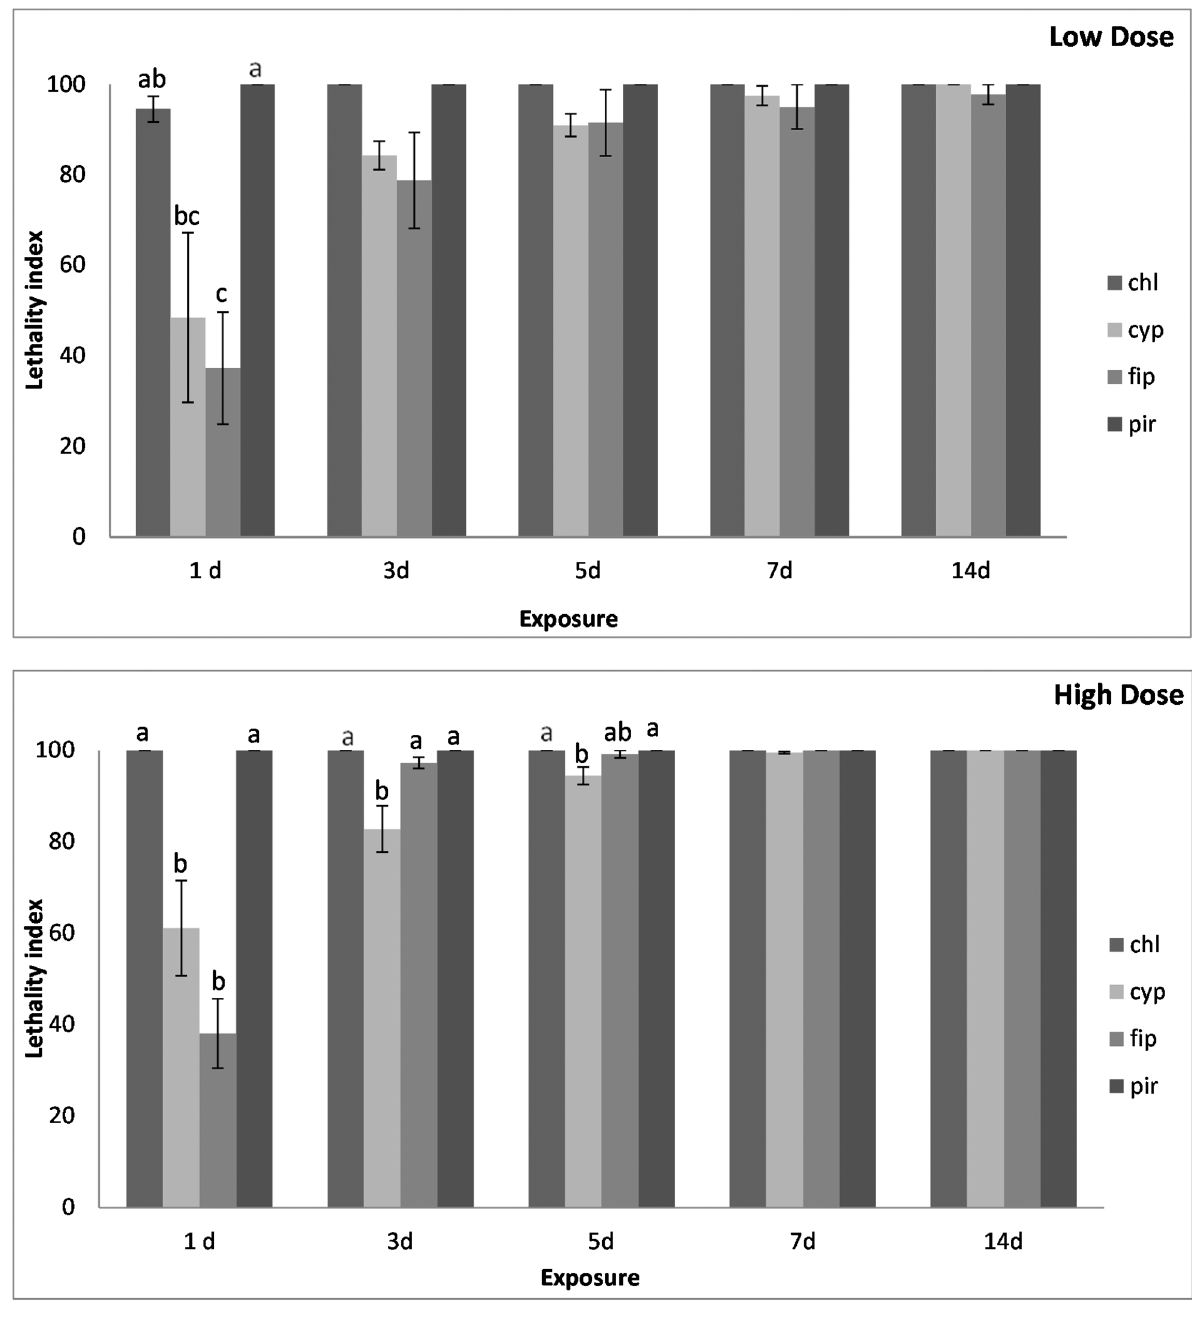
Fig 7. Lethality index of O . surinamensis adults on concrete surfaces at low and high dose. Mean lethality index ( ± SE) of O . surinamensis adults on concrete treated with chlorfenapyr (chl), alpha-cypermethrin (cyp), fipronil (fip) and pirimiphos-methyl (pir), at the low and the high dose rate of each insecticide after 1, 3, 5, 7 and 14 d of